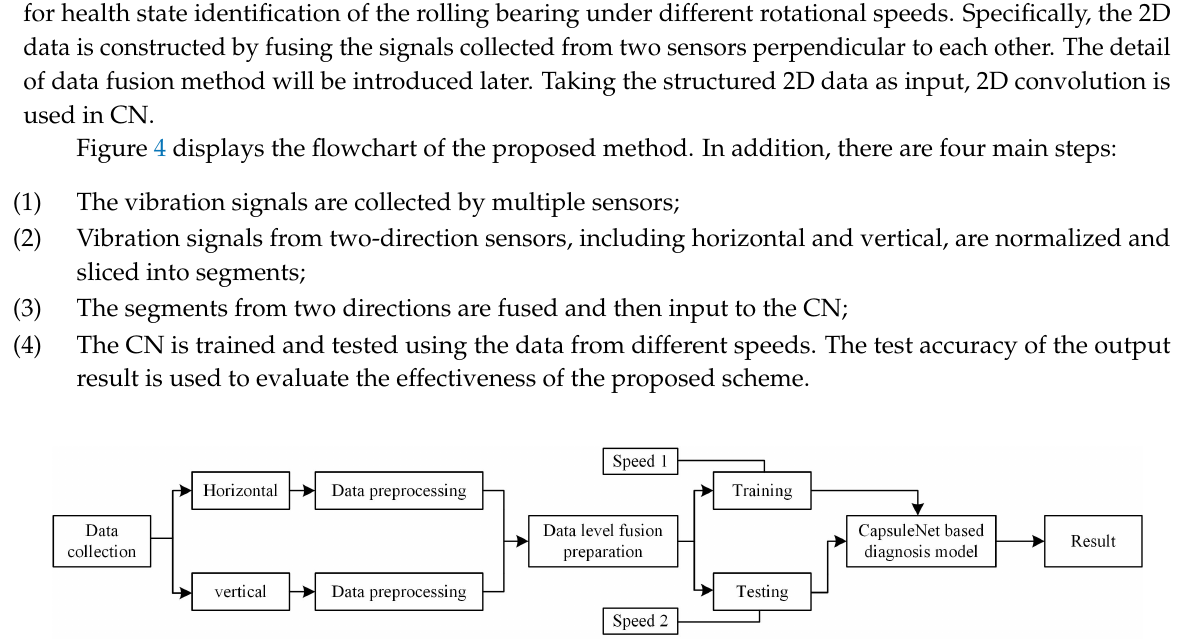
Figure 4. Flowchart of the proposed